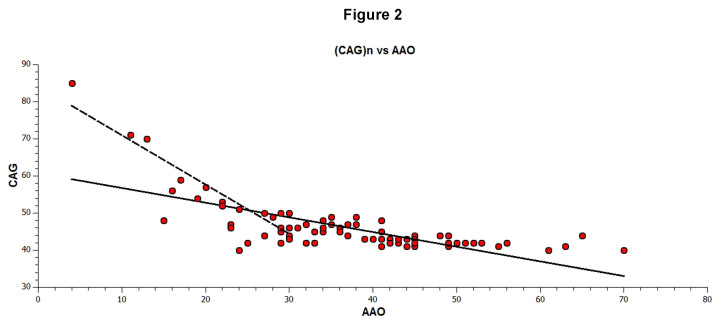
For each individual, the measured CAG repeat length in HTT allele (Y-axis) is plotted against AAO (years) (X-axis). The solid line represents the linear fit to the data. The CAG repeat length accounts for approximately 51.4% of the overall variation in AAO. The dotted line shows the linear fit for repeats >50. The CAG repeat length accounts for approximately 93.3% of the overall variation in AAO.